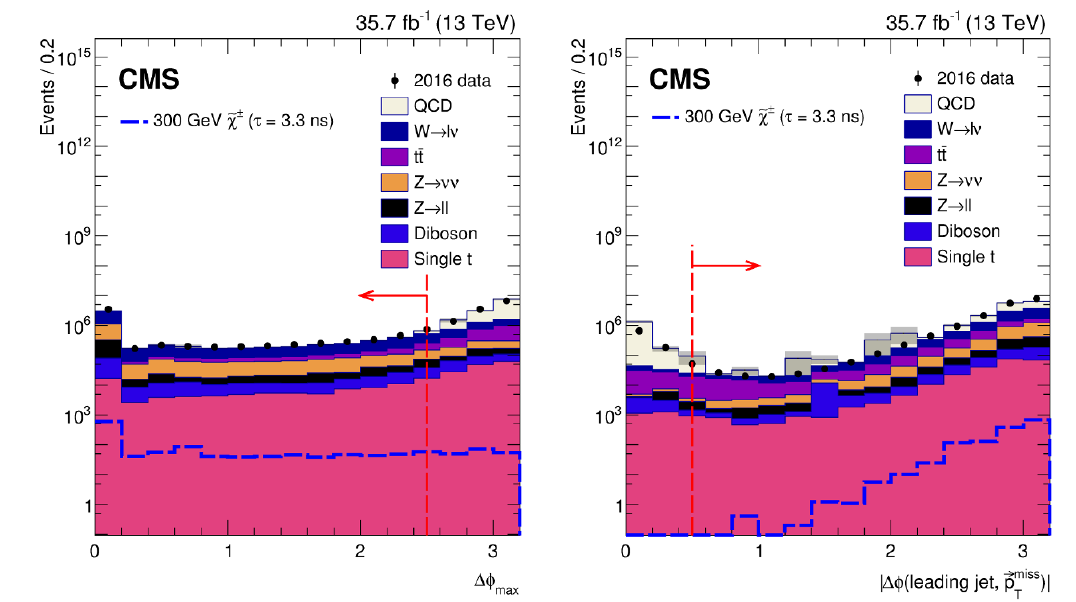
Figure 1 . Distributions of the maximum di(cid:11)erence in (cid:30) between any two jets (left) and the di(cid:11)erence in (cid:30) between the ~p T of the leading jet and ~p miss (right) for events passing the basic T selection, before either of the requirements on these two variables is imposed. The data is from the 2016 data-taking period, and the blue dashed lines show the distributions for simulated signal events with a chargino that has a lifetime of 3.3 ns and mass of 300 GeV, with a corresponding production cross section of 0.58 pb. The gray shaded area indicates the statistical uncertainty in the SM background, and the leftmost bin of the left plot includes events with only one selected jet. The vertical dashed lines indicate the chosen value for the requirement on each variable, and the arrows indicate which events are